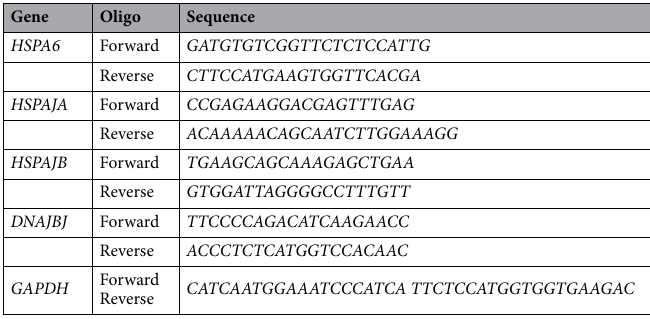
Table 2. List of primer sequences used in this